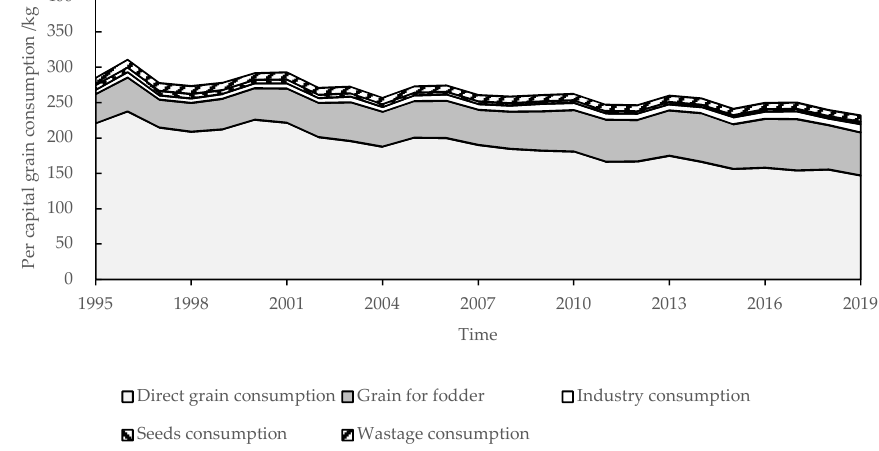
Figure 5. The structure of per capita grain consumption in the QTP from 1995 to 2019.